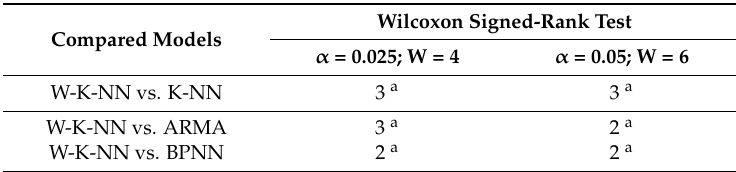
Table 8. Wilcoxon signed-rank test for the large sample. Table 7. Wilcoxon signed-rank test for the small sample.